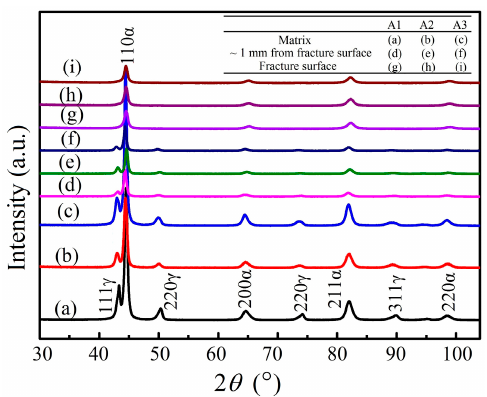
Figure 6. SEM image of fatigue fracture surface in crack propagation region of A3 sample following fatigue testing with maximum stress of 1.5 GPa and at 18,316 cycles: ( a ) Low magnification; ( b ) High magnification of the black circle.